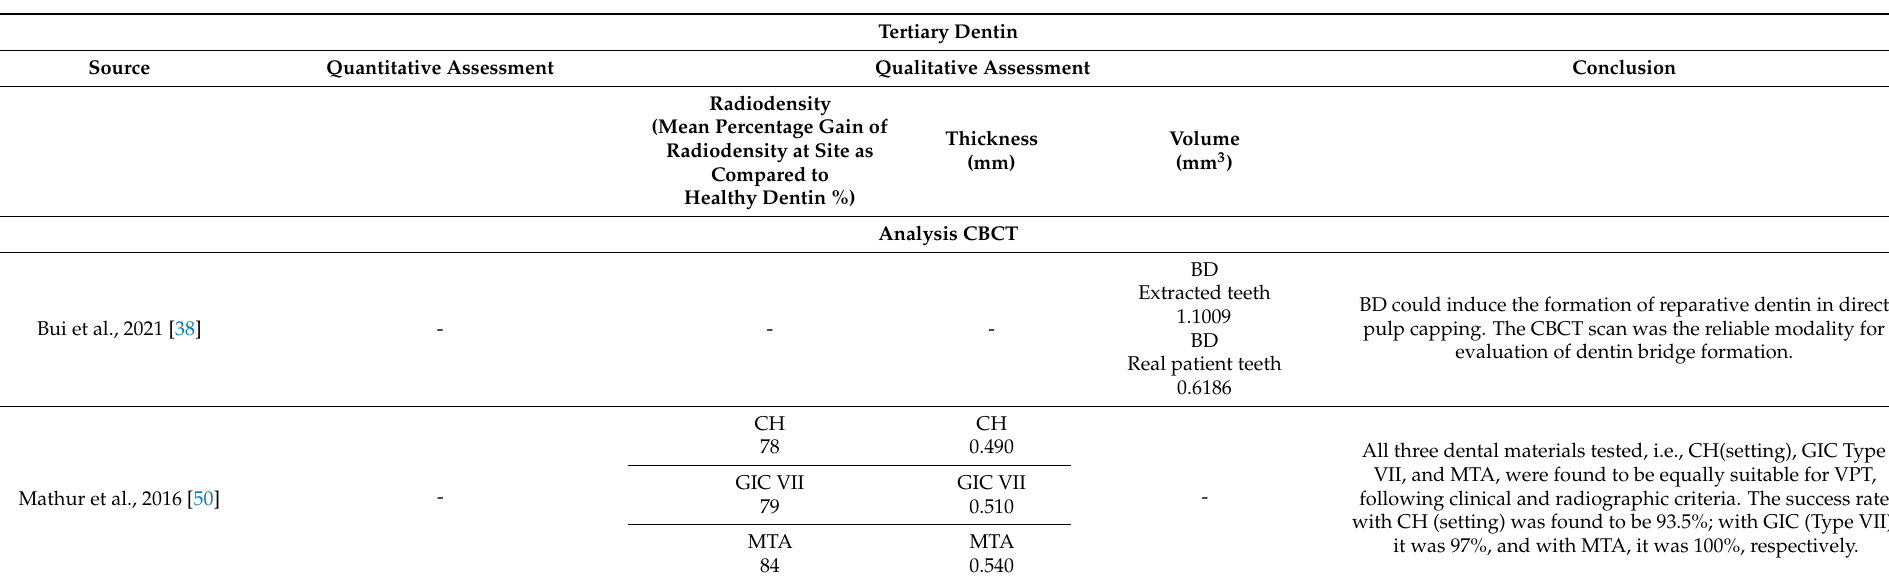
Table 8. Analysis of tertiary dentin in CBCT and